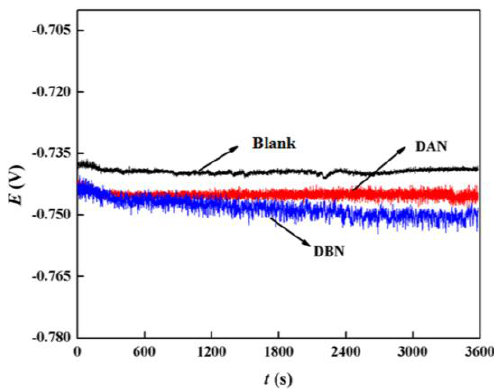
Figure 3. Open circuit potential change of AA5052 aluminum alloy in 1 M HCl without inhibitor (Blank) and with different inhibitors added (DAN or DBN), respectively.